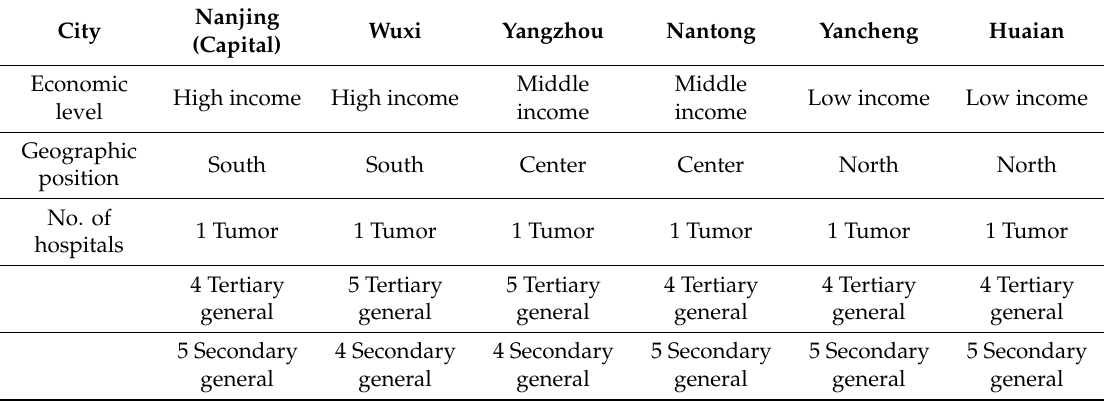
Table 1. Main characteristics of the 6 sample cities in both surveys.